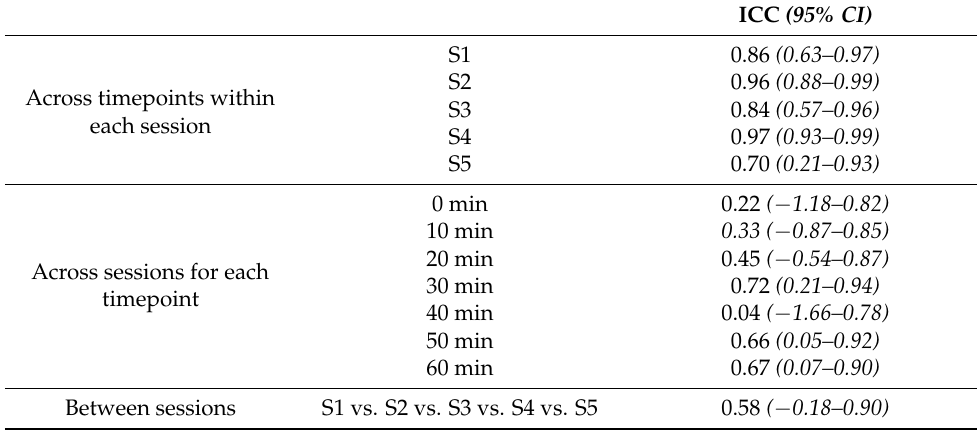
Table 5. Remaining ICCs from Study 1. In parenthesis the 95% confidence interval.